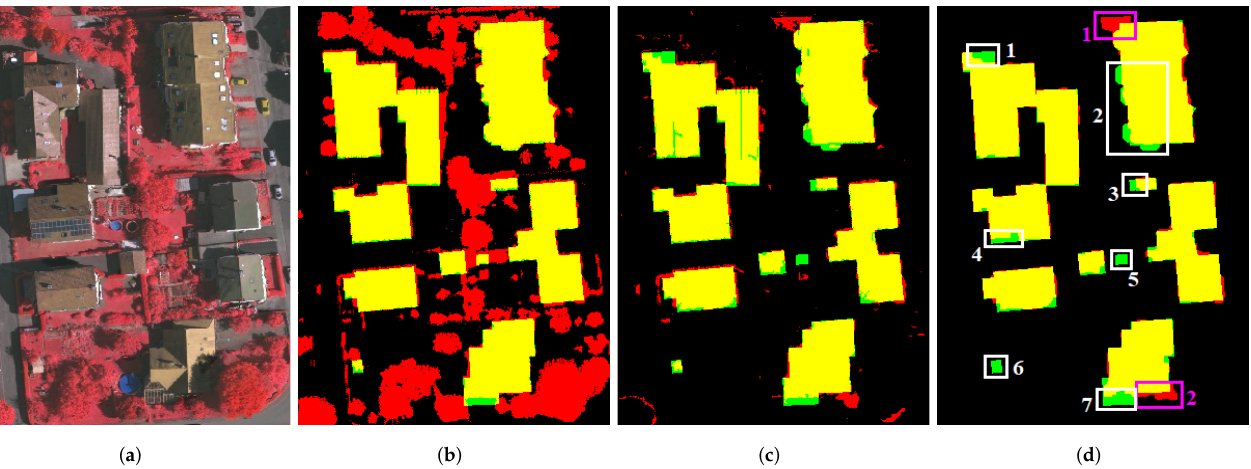
Figure 13. Illustration of some enlarged unfavourable results of our biSH+IFCC method. ( a ) Remote sensing image; ( b ) nDSM; ( c ) initial building mask (the nDSM where the vegetation recognised by the iSH+eSH method has been removed); ( d ) the final building